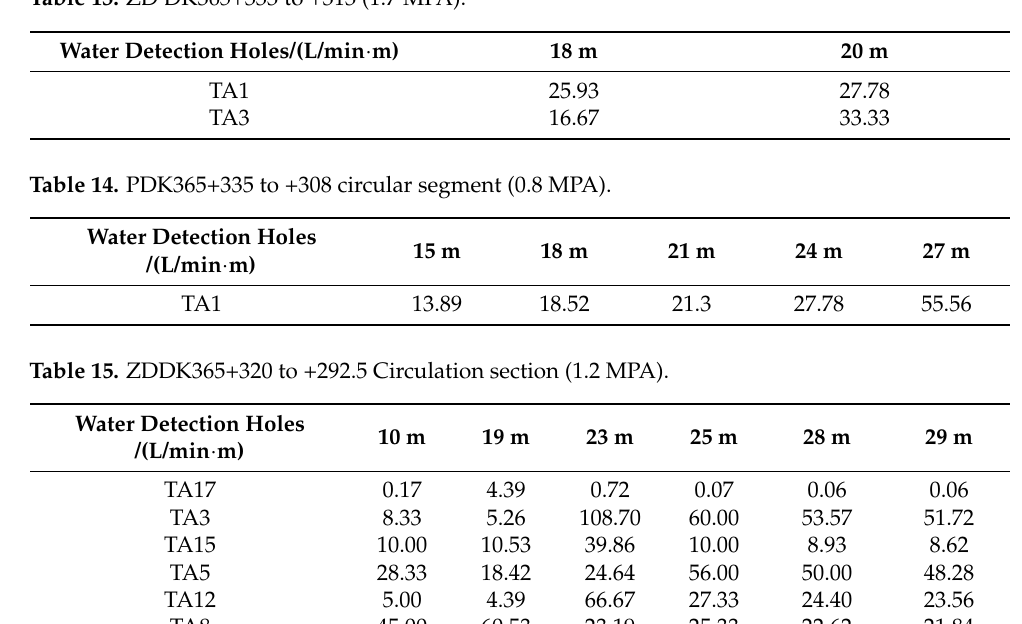
Table 13. ZD DK365+333 to +313 (1.7 MPA).